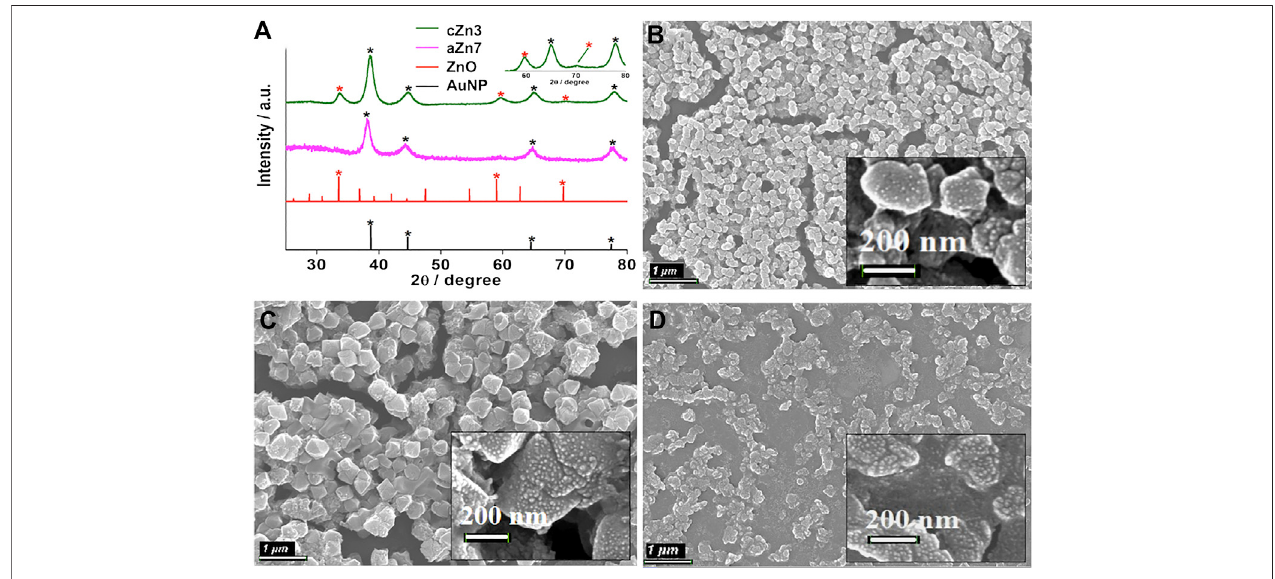
FIGURE 1 | (A) XRD of aZn7 and cZn3 compared with the AuNP (JCPDS no. 00 – 004 – 0784) and ZnO (JCPDS no. 00 – 021 – 1486); FE-SEM images of AuNP-Au- cZnO nanocomposites: (B) cZn2 , (C) cZn3 , and (D) cZn4 . The scale bar for B – D: 1 µM and the scale bar for inset images: 200 nm.